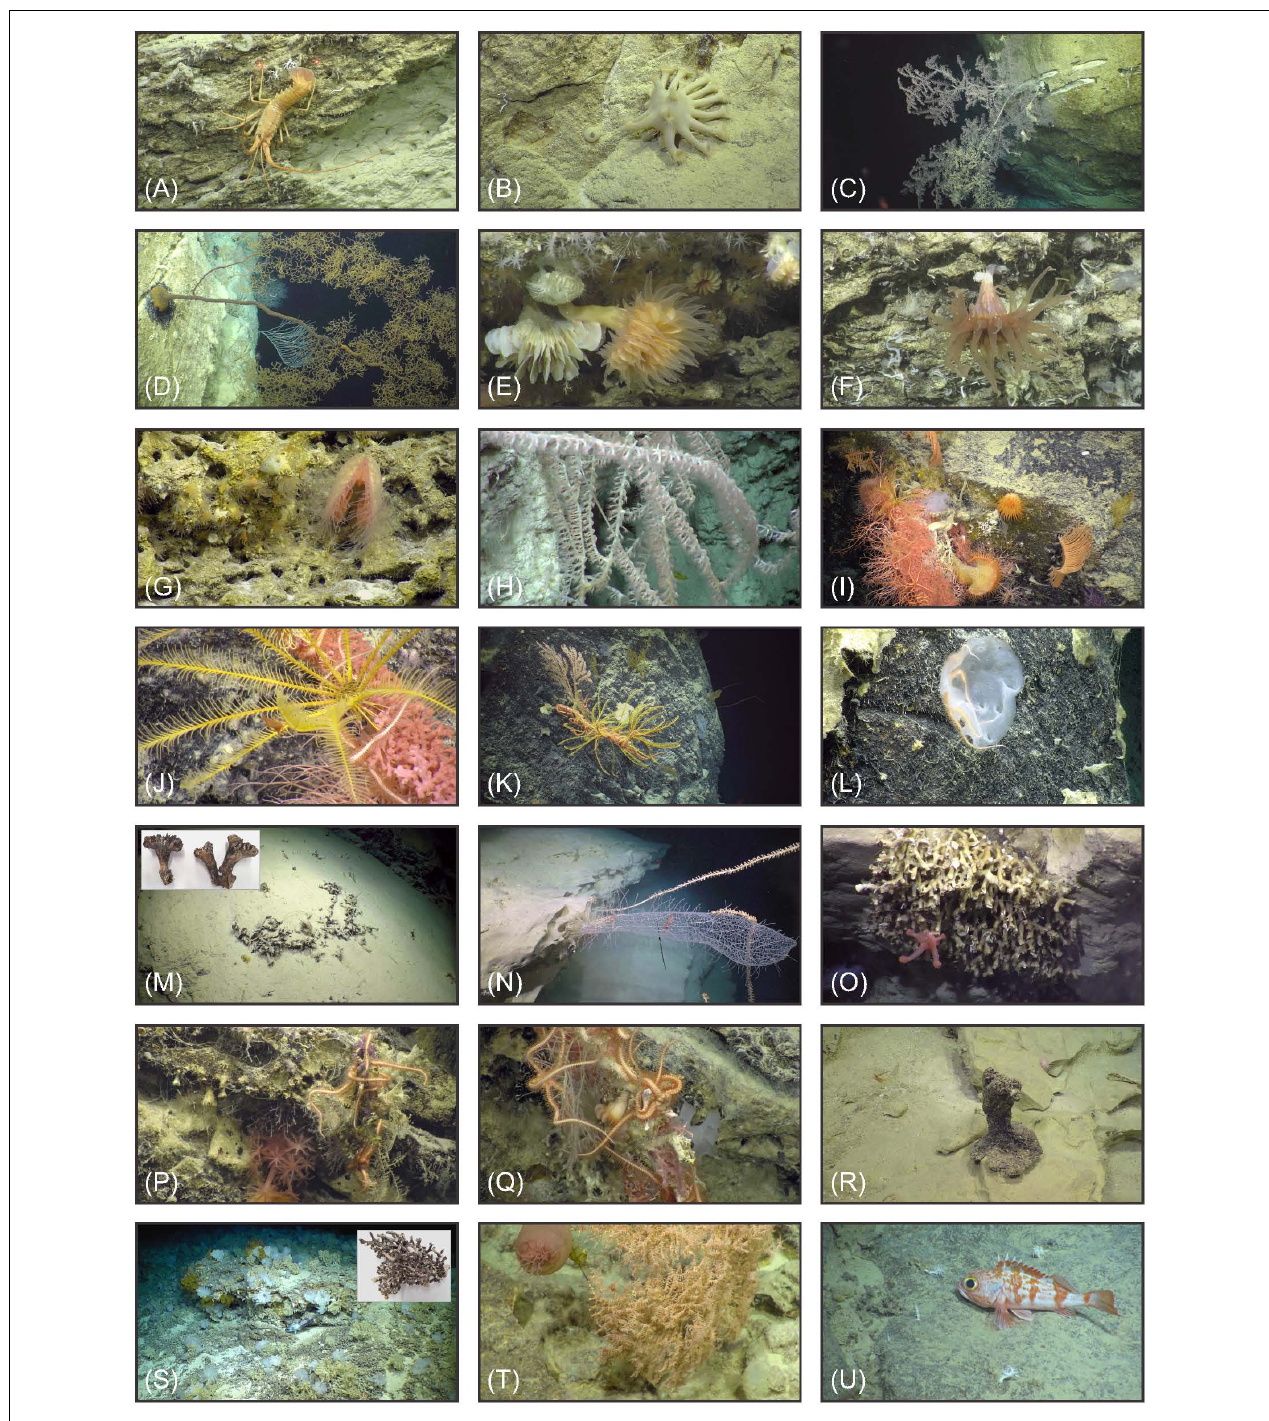
FIGURE 9 | Images of some faunas observed during the ROV dives. Site A: Lobster Projasus parkeri (A) , hermit crab Sympagurus sp. with zoanthid Epizoanthus sp. (B) , antipatharian corals (C,D) , cup corals Desmophyllum dianthus (E) and Polymyces sp. (F) , Acesta sp. bivalve (G) . Site B: bamboo coral (H) . Site C: Corallium ‘community’ hosting various taxa (I) , crinoid on Corallium sp. (J) , crinoids and brittle stars on dead bamboo coral (K) , hexactinellid sponge (L) , fossil coral deposits predominantly D. dianthus (M) . Site D: Walteria sp. glass sponge with comensal shrimp and bamboo coral (N) , Solenosmilia variabilis colony (O) . Site E: brittle stars, Anthomastus sp. and dead cup corals (P) , Corallium sp. with brittle stars and D. dianthus (Q) , Mn-coated dead Corallium stump (R) . Site F: hexactinellid sponges, crinoids, and fossil coral deposits predominantly S. variabili s (S) , pelagic holothurian and antipatharian coral (T) , Bigeye Ocean Perch Helicolenus sp. and stylasterids (U)